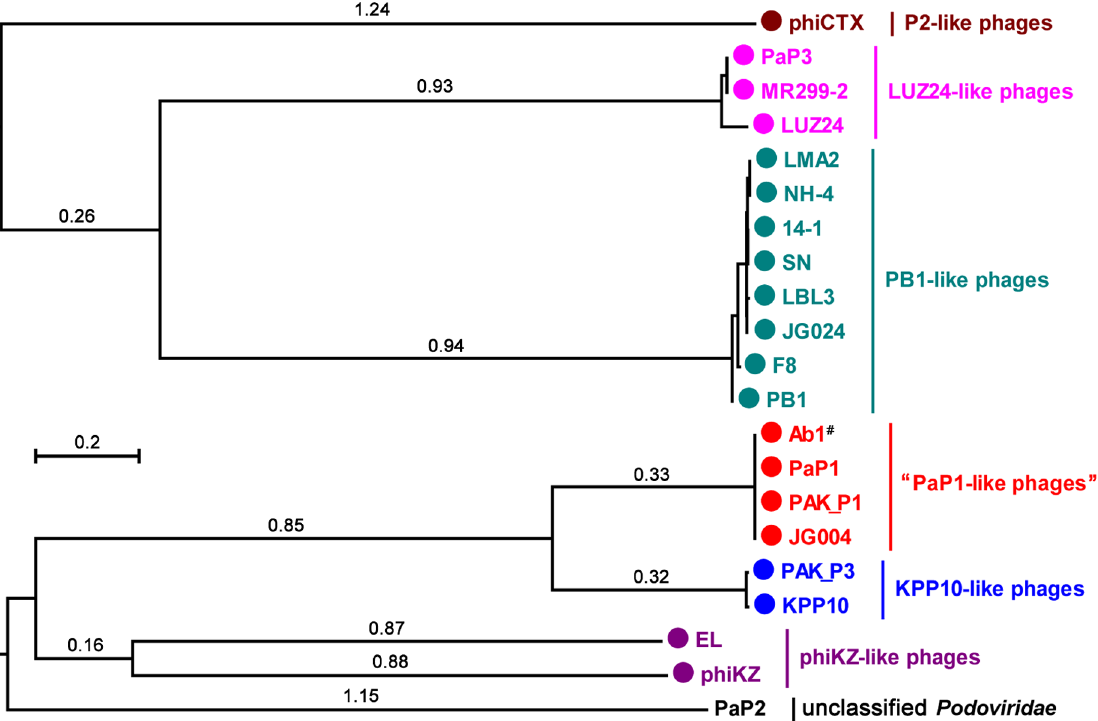
Figure 10. Phylogenetic analysis of major capsid protein amino acid sequences. The diagram was constructed using the MEGA5 program [58]. The relative distances of each main branch are shown in the figure. Both PaP2 and LUZ24-like phages belong to the family of Podoviridae ; all other phage groups belong to the Myoviridae phage family. The phages in the same group are marked with the same color. The group of ‘‘PaP1-like phages’’ is first presented in this work. # The full name is vB_PaeM_C2-10_Ab1.